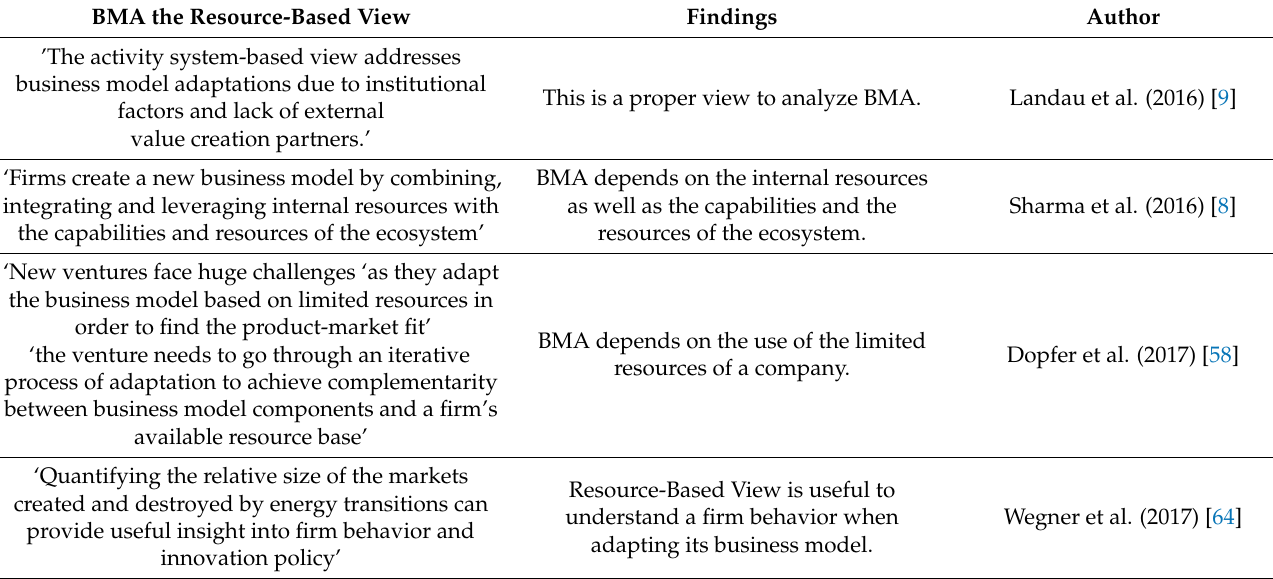
Table 15. BMA and the resource-based